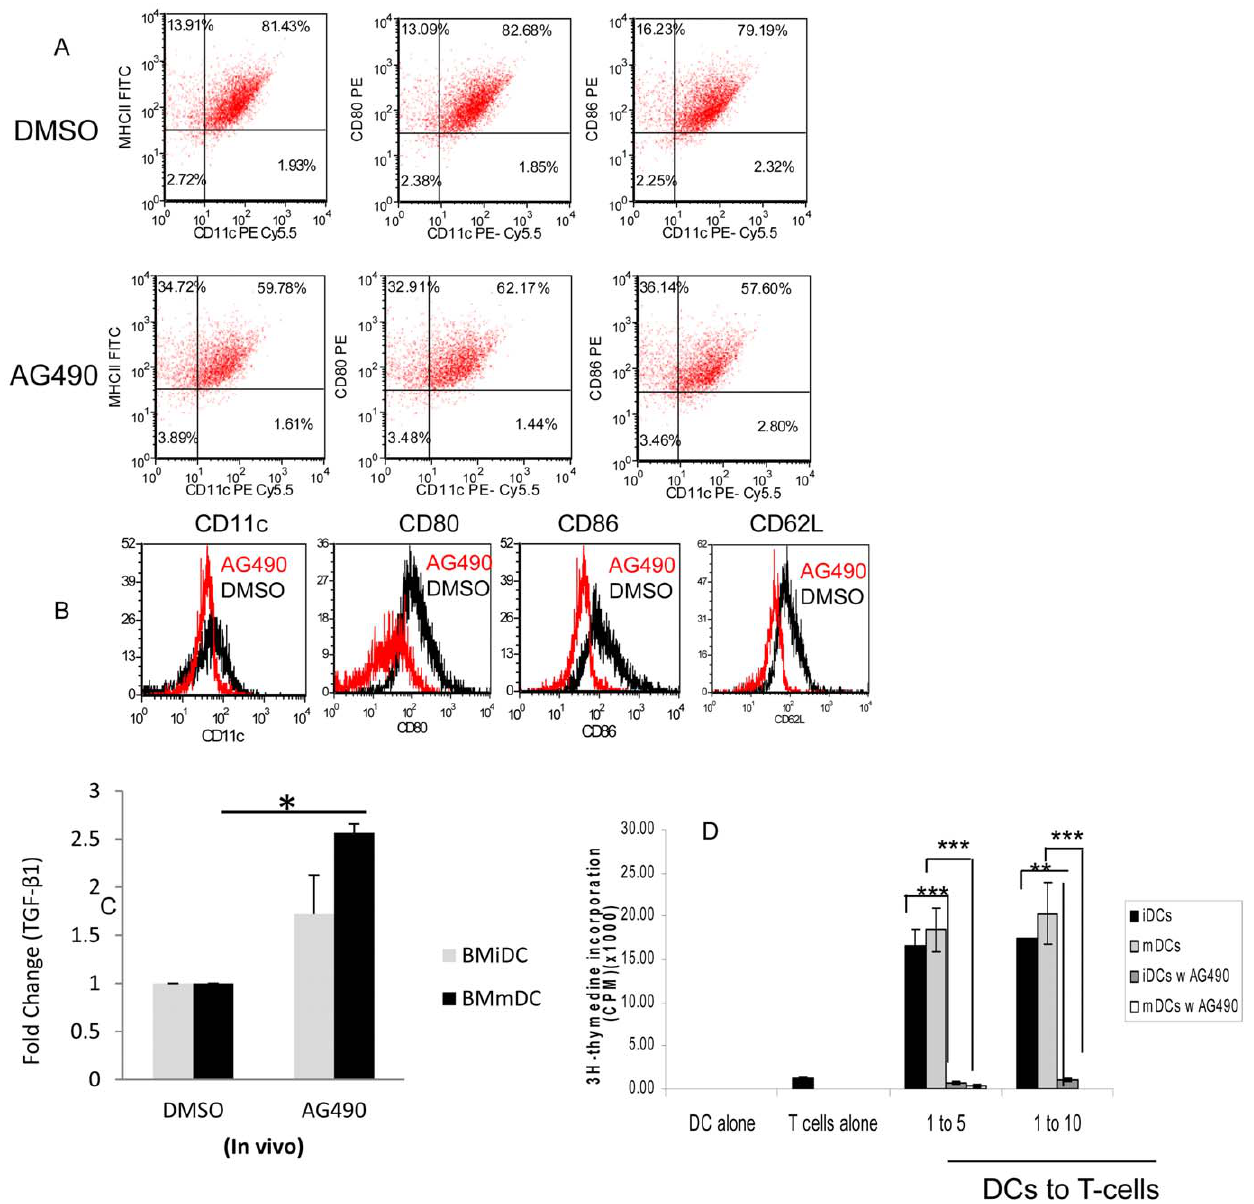
Figure 6. AG490 modulates phenotype and function of DC. A - Dendritic cells were generated from bone marrow of NOD mice treated either with AG490 or DMSO as described in materials and methods and stained directly with CD11c, MHC II, CD80 and CD86. Data shown represents CD11c gated population of pool fresh purified immature CD11c of AG490 and DMSO treated mice. B- Histograms represent expression of CD11c, CD86, CD80 and CD62L on gated CD11c population of mice treated with AG490 or DMSO in vivo . C- Bone marrow cells were isolated from NOD mice treated with AG490/DMSO for 5 weeks and then differentiated into DC in vitro as described. Total RNA (200 ng) of DC was converted into cDNA and then expression of Tgf- b 1 was measured by Real-Time TaqMan Gene expression assays (Applied Biosystems). Data represents the mean (fold change) of two real-time RT-PCR experiments and the bars represent standard deviation of the mean. Fold change of Tgf- b 1expression is shown (n=5 mice/ group, * p=0.02). D- BMDCs were generated from BALB/c mice treated in vitro with 20 m M AG490 or DMSO for 12 hrs and then co-cultured with constant numbers of CD4 + CD25 2 T-cells (1 6 10 5 ) with soluble anti-CD3 (2.5 ng/ml) for 72 hrs. Incorporation of 3 H-thymidine was measured in the last 16 hr of cell culture. Experiment was performed in triplicate format and repeated at least twice. Data analysis was performed using the student t - test and p value # 0.05 considered significant. Bars represent deviation of the mean (* p=0.002, **p=0.0002; ***p=0.001). [Figures A & B are intended to be in color online and black and white in